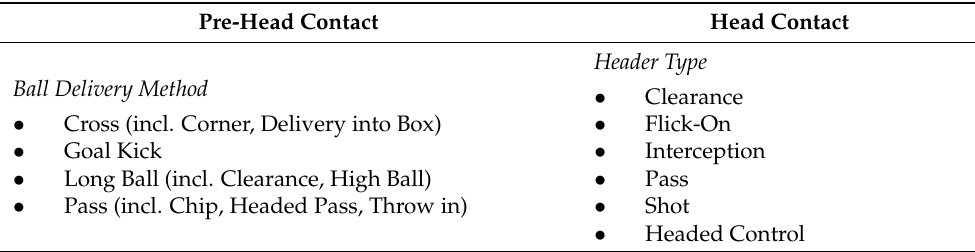
Figure 1. ( a ) The placement of digital cameras to record multi-angle, time-synchronized footage of header impacts, in combination with the ( b ) instrumented mouthguard utilized for the study. Sec- tion ( c ) summarizes the methodology of video analysis utilized to categorize each HAE into a con- tact scenario. Table 1. Variables used to categorize header impacts through video incident analysis.